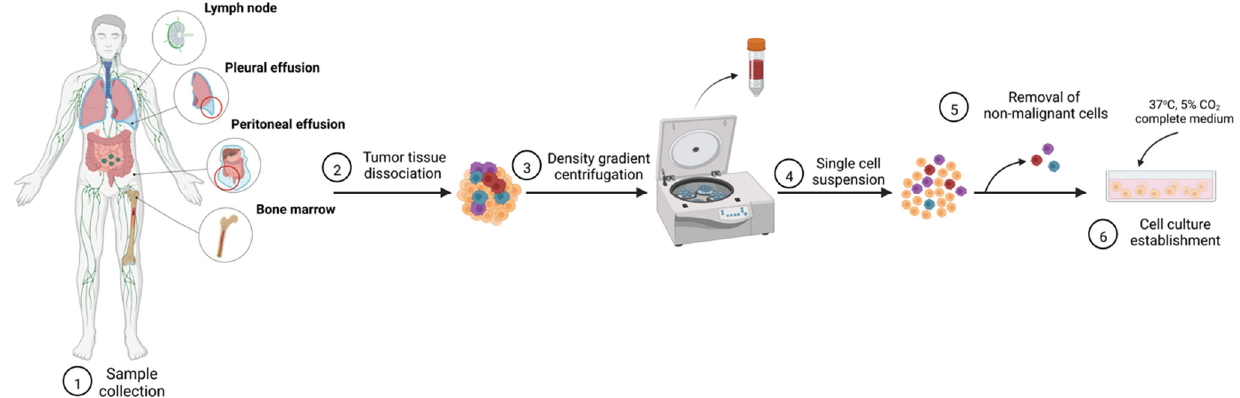
Figure 1. Establishment of patient-derived cell line models. Created with BioRender.com, accessed on 30 October 2022.